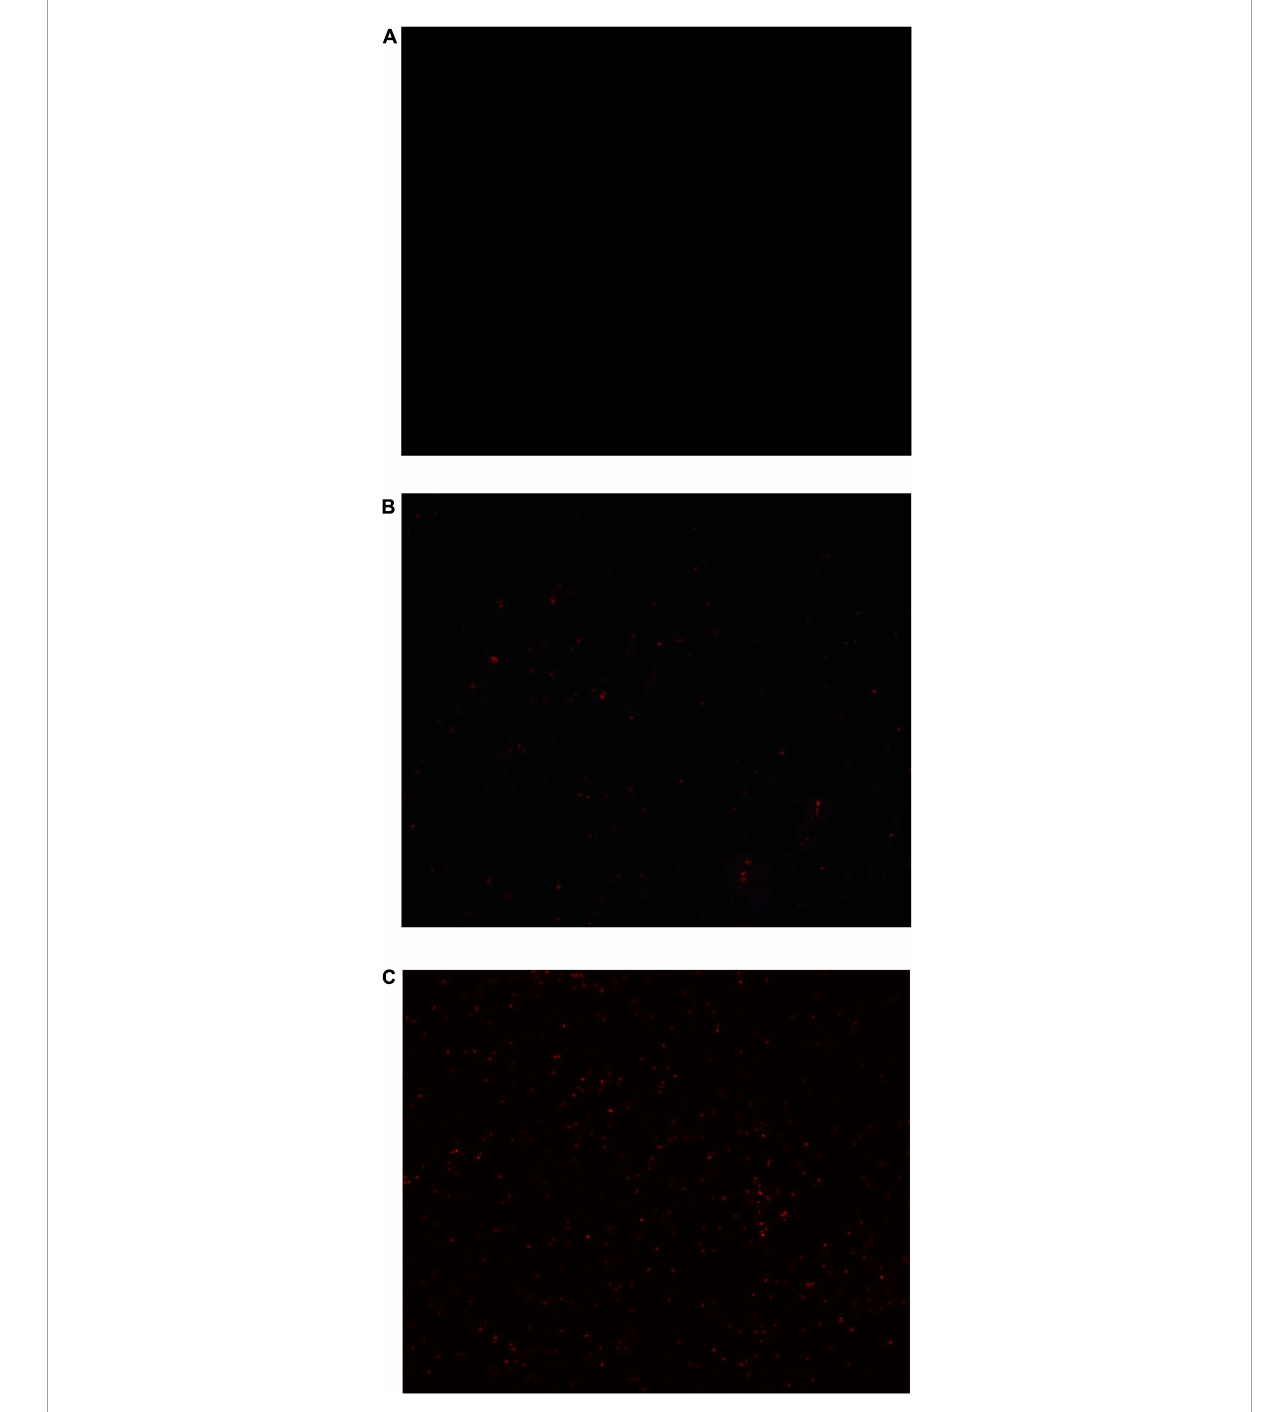
FIGURE6 Images of Staphylococcus aureus treated with anthocyanin (respective MIC and 2 MIC) by fluorescent inverted microscope. (A) Is the control group; (B) is the anthocyanin (MIC)-treated group; (C) is the anthocyanin (2 MIC)-treated group.